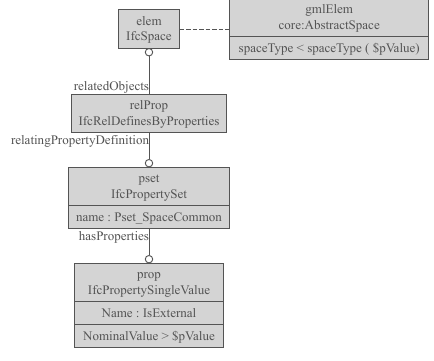
Figure 7. A rule converting a property to a direct attribute, here the IsExternal property of IfcSpace in IFC to the spaceType attribute in